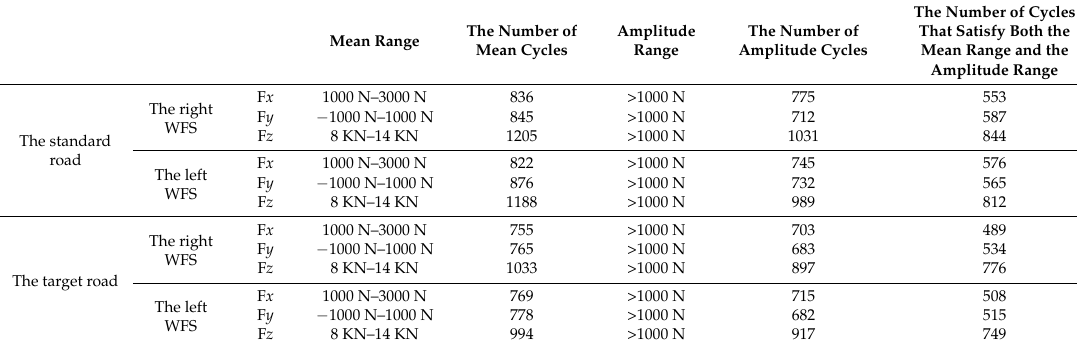
Table 1. Rain flow counts after quantification of each dimension load. Mean Range The Number of Mean Cycles Amplitude Range The Number of Amplitude Cycles